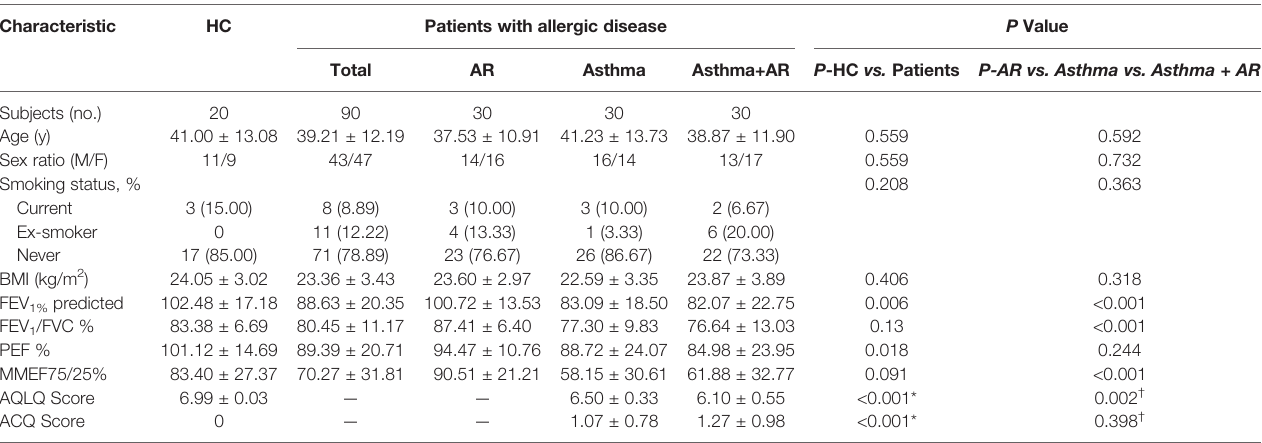
Values are mean ± SD or n (%). HC, healthy controls; D, diseased; AR, allergic rhinitis; Asthma + AR, asthma and comorbid AR. BMI, body mass index; M, male; F, female; FEV1, forced expiratoryvolumeinthe fi rst second;FVC,forced vitalcapacity;PEF,peakexpiratory fl ow;MMEF75/25,maximalmid-expiratory fl ow;ACQ,theAsthmaControlQuestionnaire;AQLQ,the AsthmaQualityofLifeQuestionnaire;NA,notapplicable.ContinuousvariableswerecomparedbyOneWayANOVA.CategoricalvariableswerecomparedbyPearson ’ schi-squaretestor Fisherexacttest.*Mann-WhitneyUtestfortotalpatientsincludedasthmaandasthmacomorbidARpatientscomparedtoHCgroup(2groupcomparison). † studentt-testforpatientswith asthma compared to asthma comorbid